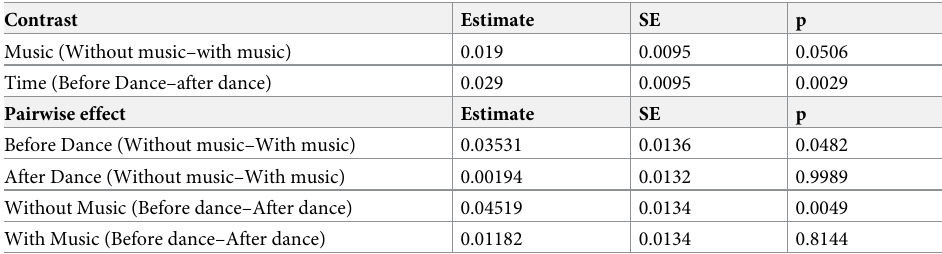
Table 4. Contrast main and pairwise